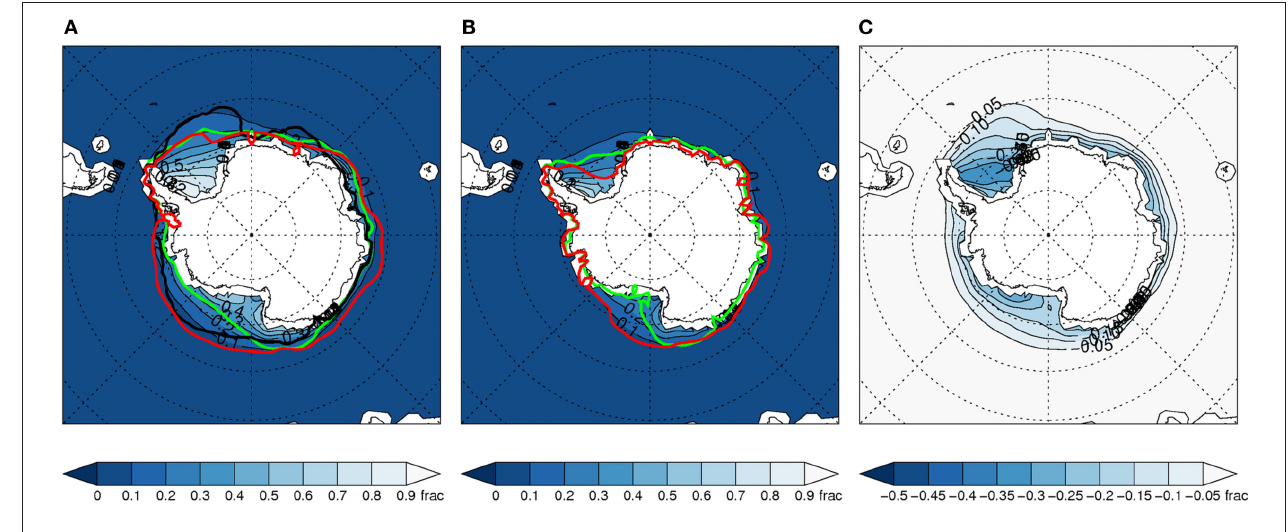
FIGURE 3 | As Figure 1 above, but for the subset of 8 models.